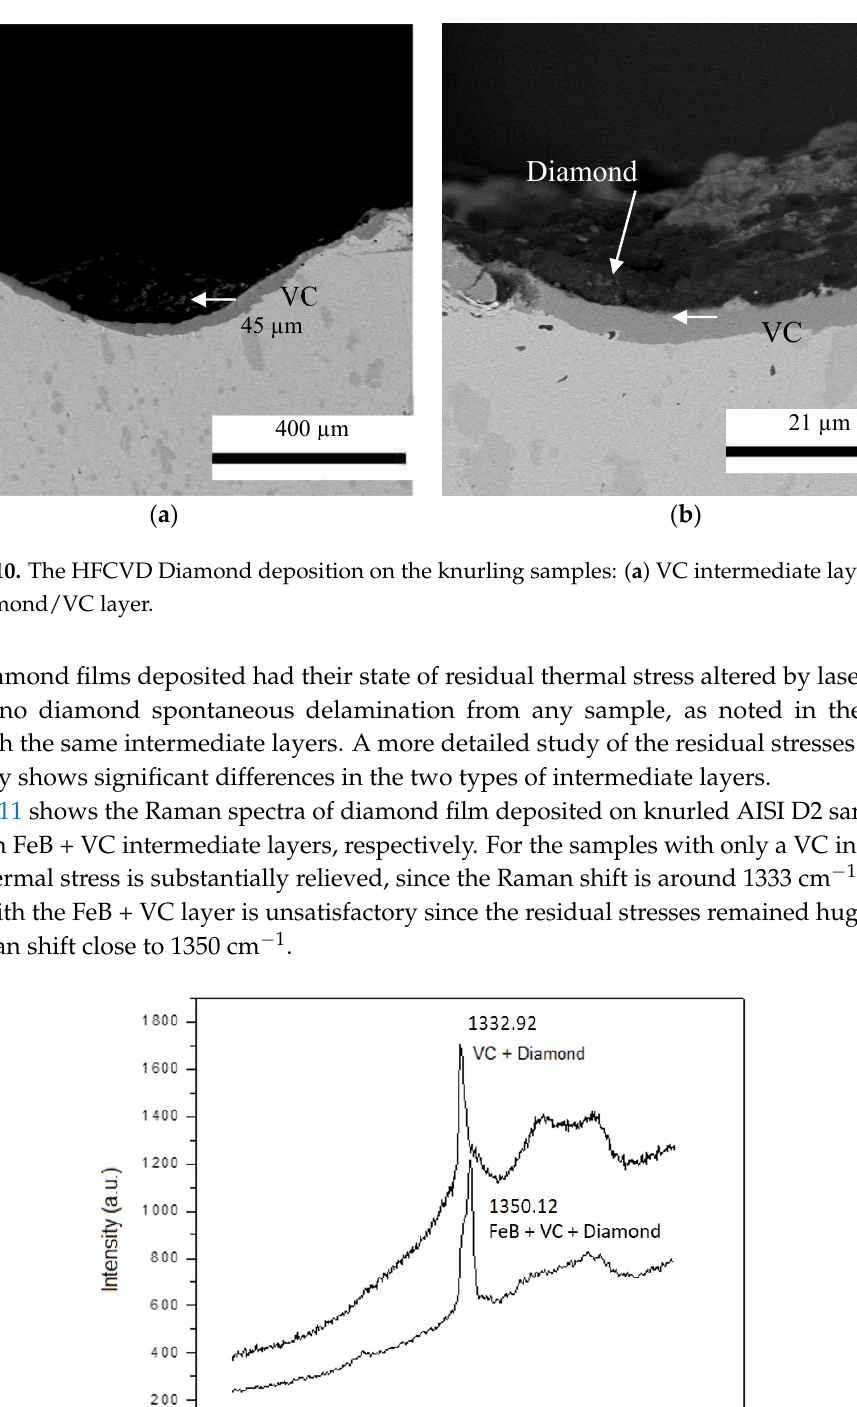
Figure 9. Cross ‐ section SEM image of the knurled and borided double ‐ layered Fe 2 B and FeB.